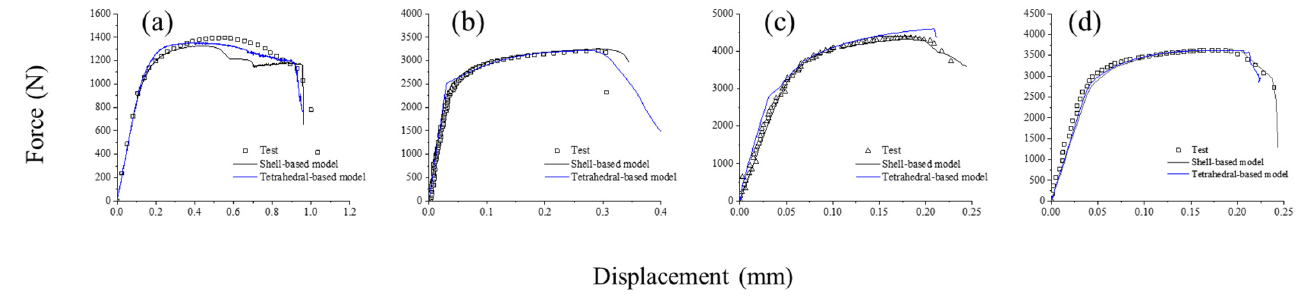
Figure 9. Shell-based model simulation vs. experiments for MAT 1 using GISSMO: ( a ) shear specimen, ( b ) tensile specimen, ( c ) center hole specimen, and ( d ) R5 specimen.